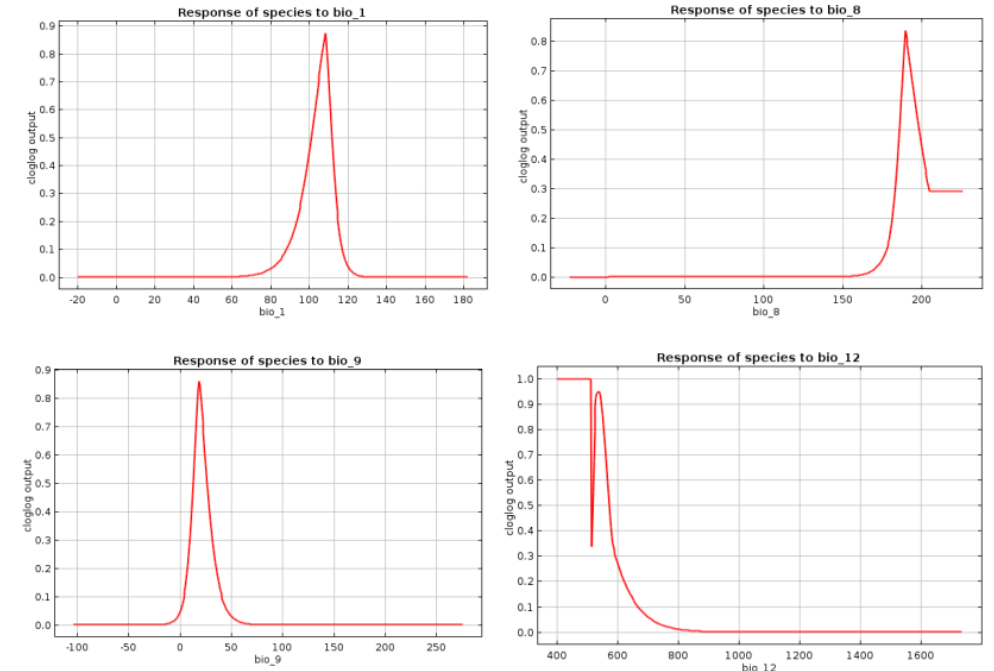
Figure A2. Response Curves of the Selected Bioclimatic Variables